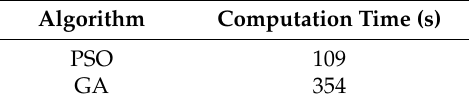
Figure 12. Convergence of PSO and genetic algorithm (GA). Table 5. Computation time of PSO and